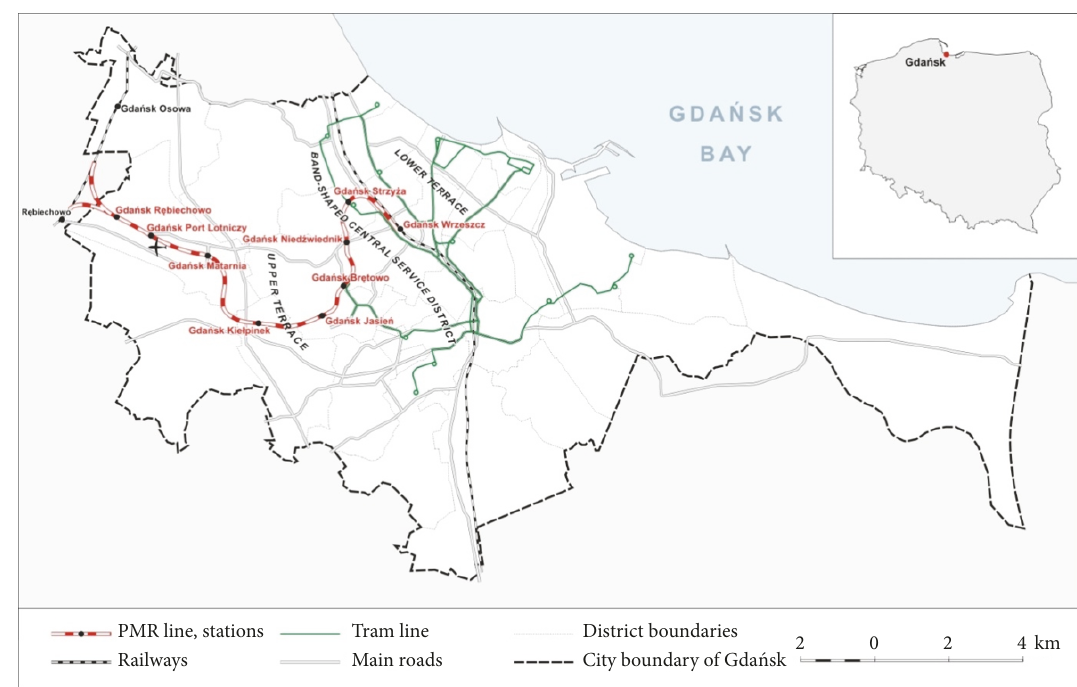
Figure 1: The Pomeranian Metropolitan Railway line within the city of Gda´nsk